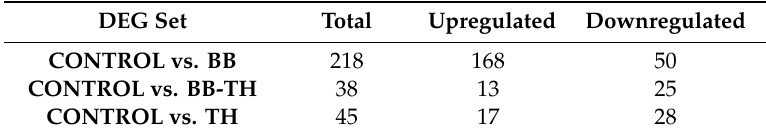
Table 3. Number of differentially expressed genes in O. furnacalis in response to fungal infection. DEG Set Total Upregulated Downregulated CONTROL vs. BB 218 CONTROL vs. BB-TH CONTROL vs.